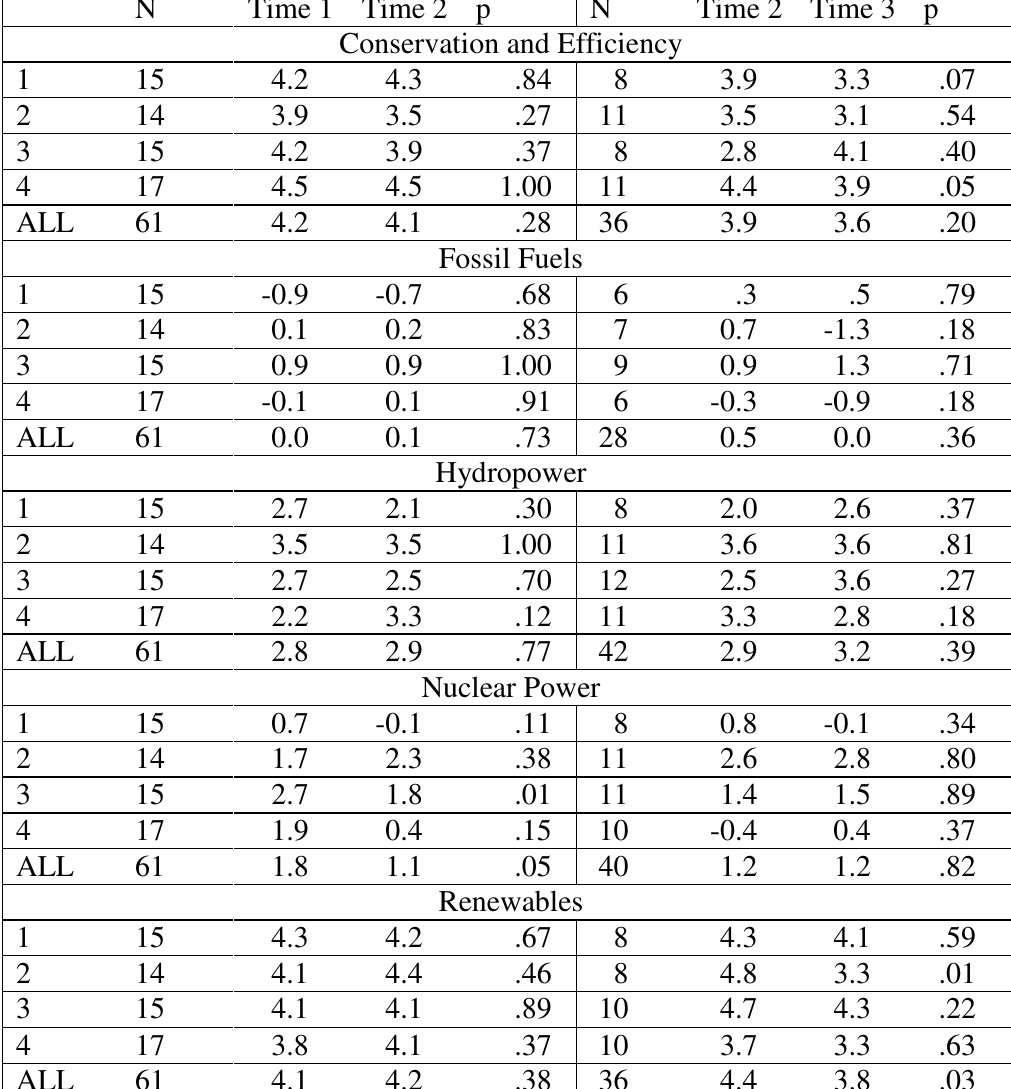
Table 2. Mean Rating of Energy Options by Treatment, Pre-Test vs. Post-Test and Post-Test vs. Delayed Post-Test (Paired